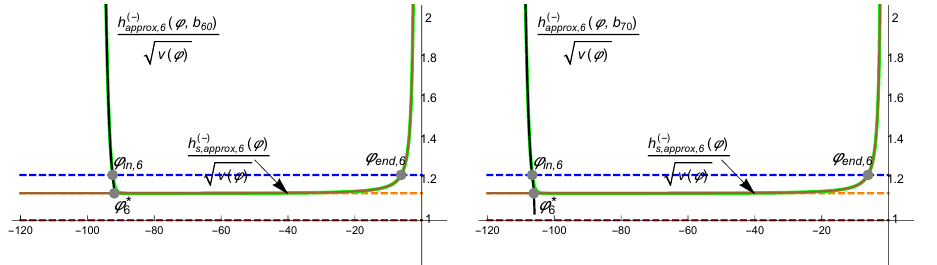
Figure 9. The green lines show the numerical solution h ( − ) ( ϕ ) of (89) with initial conditions ϕ 0 = − 100, h = h ( − ) ( ϕ ) / (cid:112) v ( ϕ ) (left) and ϕ = − 300, h = h ( − ) ( ϕ ) / (cid:112) v ( ϕ ) (right) 0 0 , b 60 0 0 0 0 , b 70 0 approx ,6 approx ,6 √ √ 3 2 for the model with potential (11) with λ = , µ = , c 1 = 2 × 10 − 10 , c 2 = 2.5 × 10 − 10 . The black 3 4 ( − ) ( ϕ , b ) / (cid:112) v ( ϕ ) ( left ) and h ( − ) ( ϕ , b ) / (cid:112) v ( ϕ ) ( right ) lines show the KD approximation h 60 70 approx ,6 approx ,6 ( − ) ( ϕ ) / (cid:112) v ( ϕ ) . The regions between blue and red and the brown lines the SR approximation h s , approx ,6 dotted lines are the inflation regions. The orange dotted lines correspond to the asymptotic behaviour of the separatrix solution h s ( ϕ ) ∼ ( 1 − λ 2 ) − 1/2 as ϕ → − ∞ . The gray dots correspond (from left ( b ) and ϕ ( b ) , ϕ ∗ ( b ) and ϕ to right) to ϕ in ,6 ( b 60 ) , ϕ ∗ 60 70 70 end ,6 ( left figure) and ϕ in ,6 end ,6 ( right 6 6